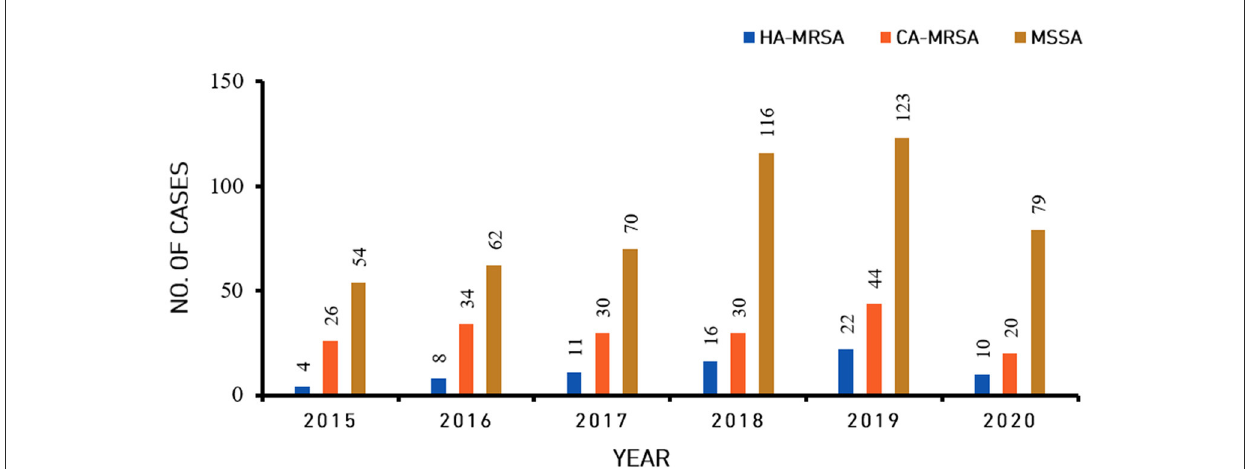
FIGURE1 Incidence of community-associated methicillin-resistant Staphylococcus aureus (CA-MRSA), healthcare-associated methicillin-resistant S. aureus (HA-MRSA) and methicillin-sensitive S. aureus (MSSA) isolates from skin and soft tissue infections from 2015 to 2020.